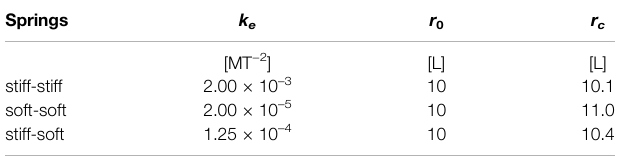
TABLE 1 | Constants of linear fracture spring.